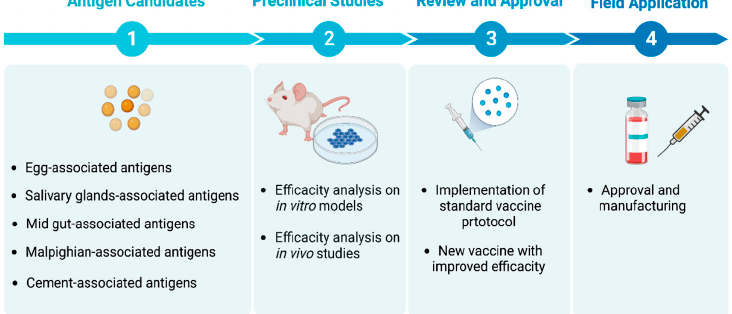
Figure 1. An overview of the distribution and efficacy evaluating scheme of tick vaccine antigens targets for the prevention of tick infestations and tick-borne diseases.